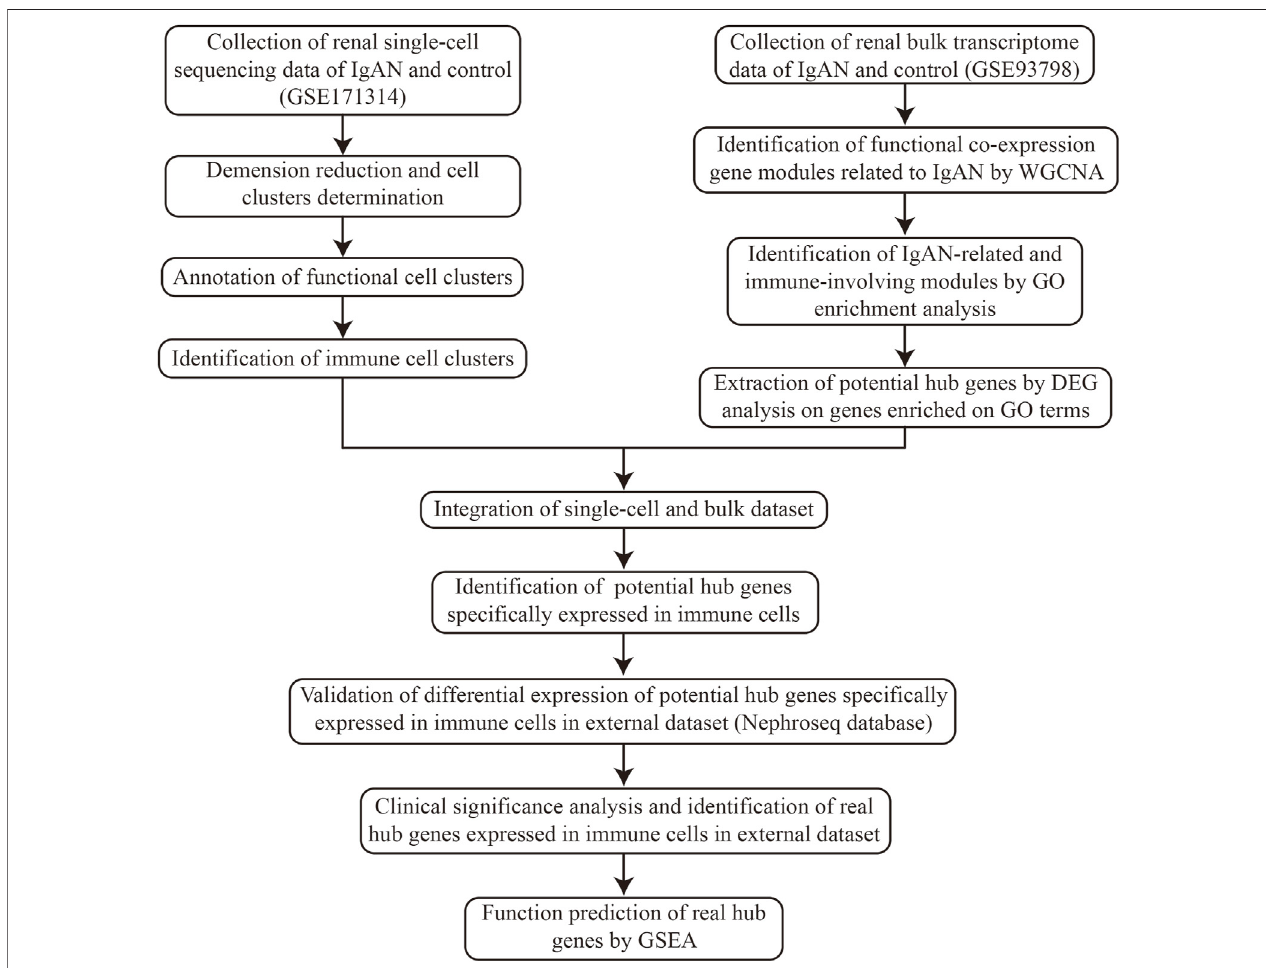
FIGURE 1 | Work fl ow of the design and overall procedures of this study.